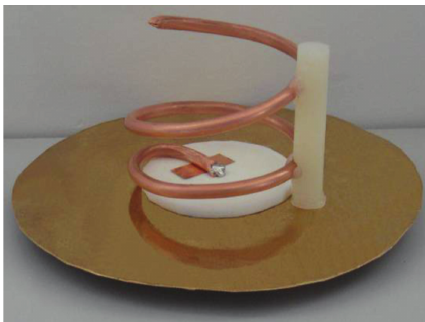
Figure 4: The fabricated antenna prototype.